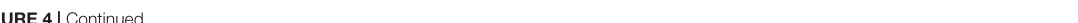
FIGURE 4 | Continued to that region. (D) Green fluorescence levels in larvae exposed to aged ERSE ( n = 15). The black dotted line represents the average of the control group, while the dashed orange lines indicate the fluorescence values obtained from animals exposed to PAH-NanoPS. Data were analyzed by one-way ANOVA followed by Tukey’s post-hoc or Kruskal-Wallis followed by Dunn’s post-hoc for (A) , and one-way ANOVA followed by Dunnet’s post-hoc or Kruskal-Wallis followed by Dunn’s post-hoc for (D) . Groups not sharing letters are statistically different ( p < 0.01) when compared to the Ctl group (A), and ** ( p < 0.01) or *** ( p < 0.001) represents statistical differences against the Ctl group (D) .